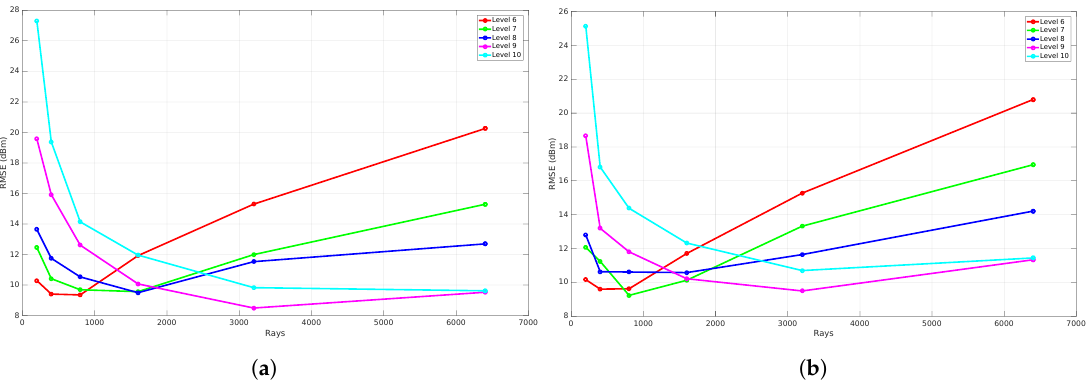
Figure 16. RMSE validation with phases shifts included of office Environment 1. ( a ) zero neighbors are included; ( b ) eight neighbors are included.